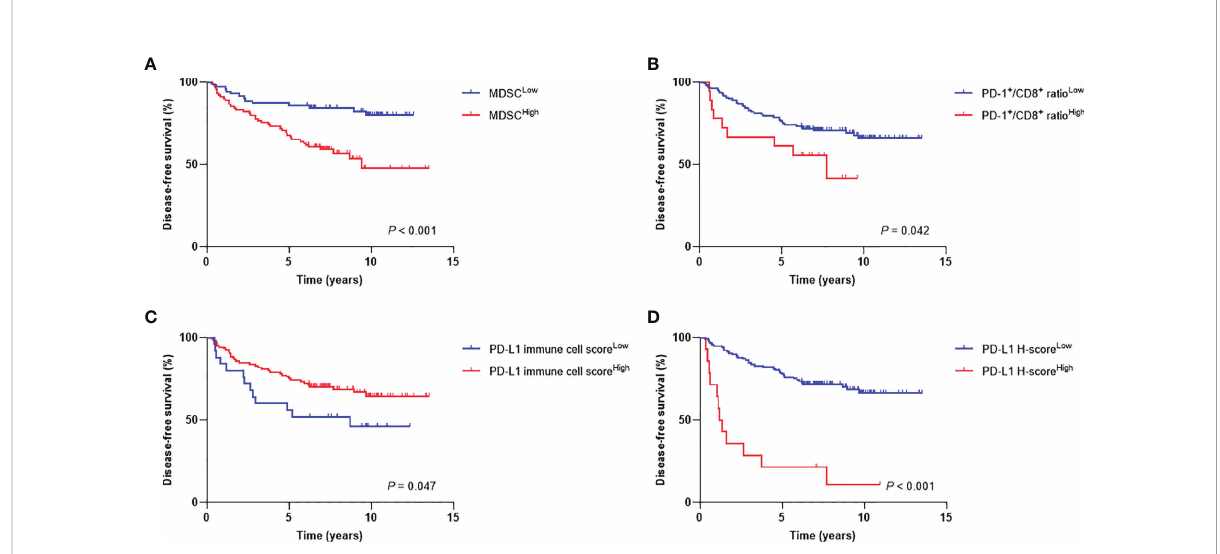
FIGURE 4 Disease-free survival curves according to high and low levels of (A) MDSCs, (B) PD-1 + /CD8 + TIL ratio, (C) PD-L1 immune cell score, and (D) PD- L1 H-score. MDSC, myeloid-derived suppressor cell; PD-1, programmed cell death-1; TIL, tumor-in fi ltrating lymphocyte; PD-L1, programmed death-ligand